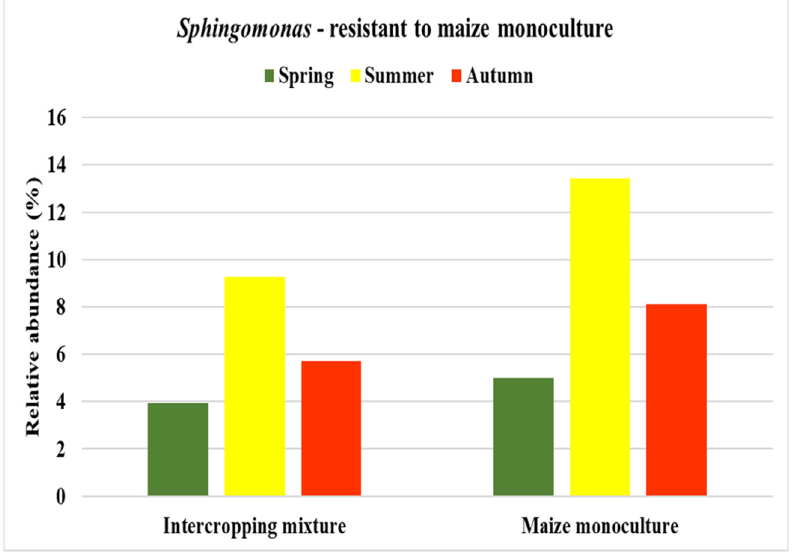
Figure 9. Bacterial genus recommended as resistant to maize monoculture in all studied seasons.